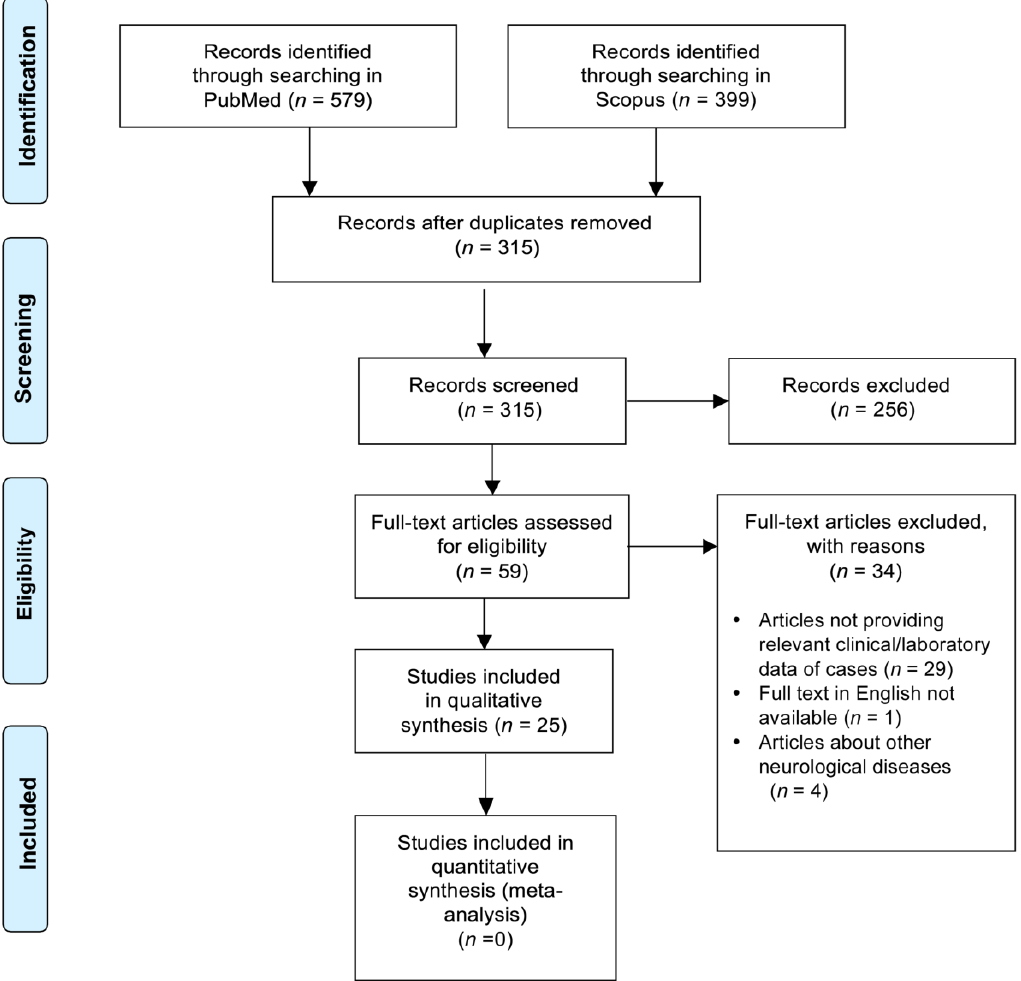
Figure 2. Preferred Reporting Items for Systematic Reviews and Meta-Analyses (PRISMA) flow diagram of study selection.